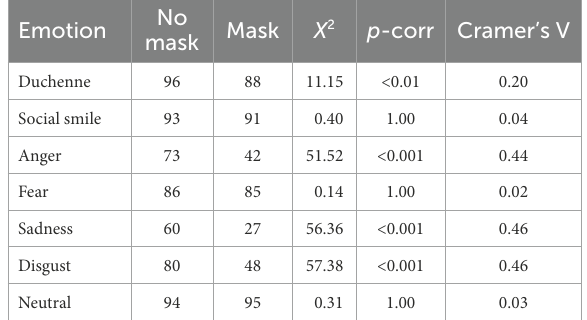
TABLE 1 Mean percentage of recognizing the displayed emotion without and with a facial mask, the result from the Chi-square comparison and effect sizes (Cohen’s